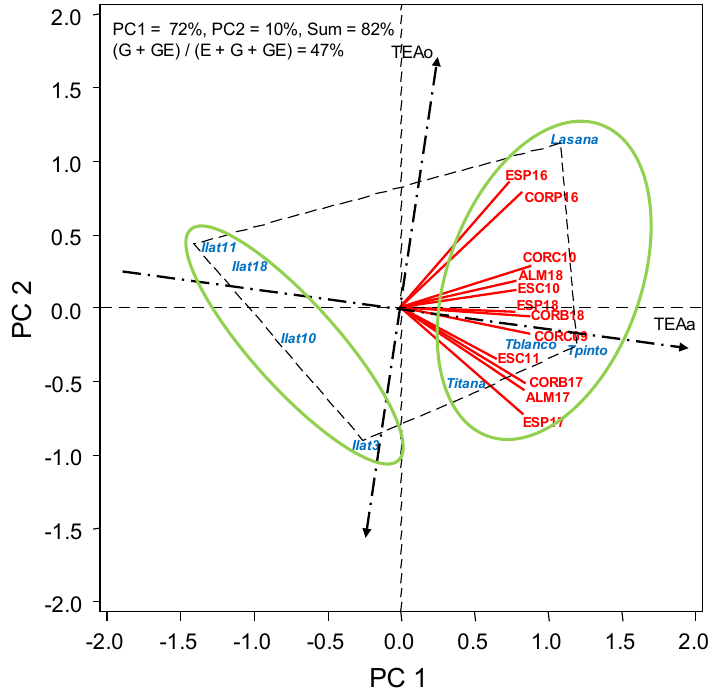
Figure 3. HA-GGE biplot based on the flowering date of 8 selected grass pea accessions in 12 environments (combination season–location).